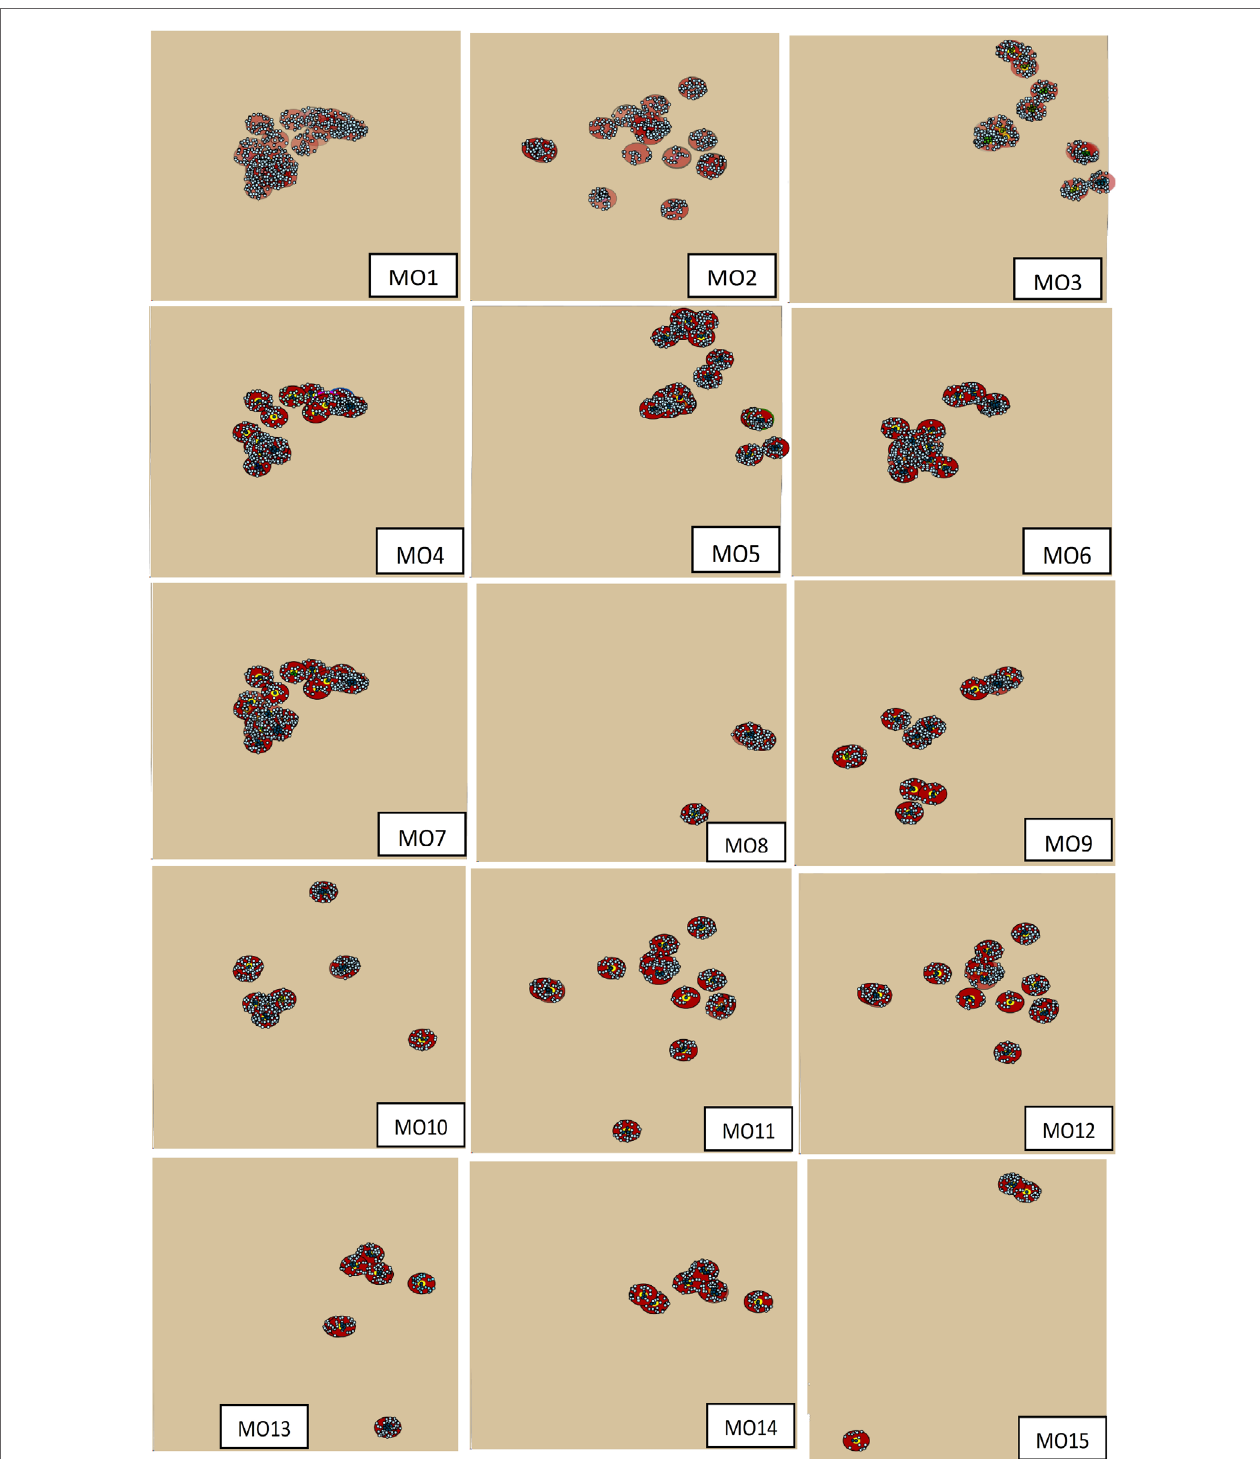
FigUre 1 | The distribution of index swine premises and the outbreak control zones for the 15 most likely multiple-site classical swine fever outbreak scenarios (MO1 to MO15). The dots are the swine premises and the circles are the control